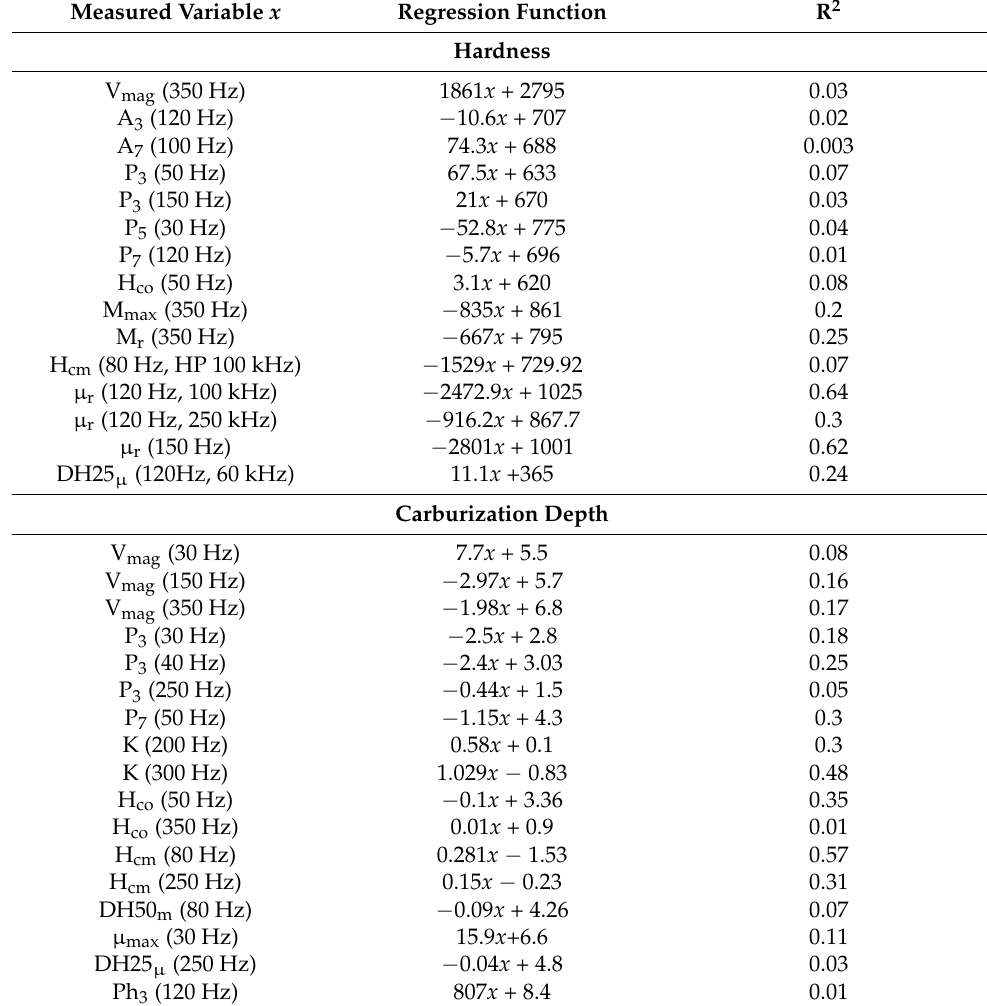
Table A2. Correlation of various measured variables with hardness and carburization